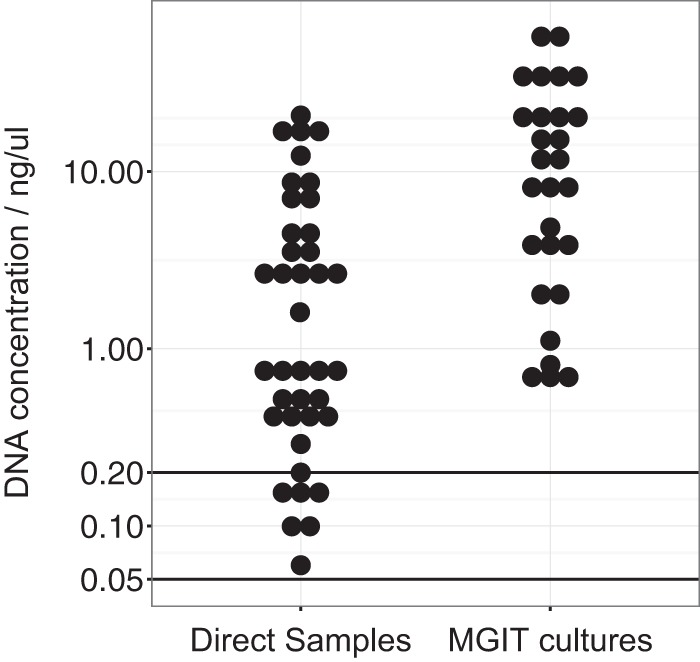
Concentrations of DNA extracted from MGIT cultures and direct clinical samples. Each dot represents a single extraction. The horizontal line at 0.2 ng/μl represents the DNA concentration theoretically required for MiSeq library preparation. The horizontal line at 0.05 ng/μl represents the minimum DNA concentration used for MiSeq library preparation from direct samples in this study. One sample not shown as DNA was below the limit of detection.